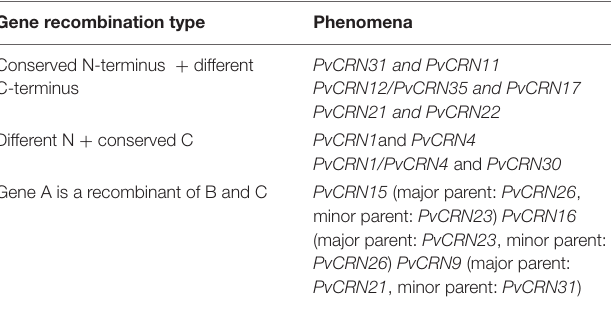
TABLE 3 | Gene recombination events found in the PvCRN gene